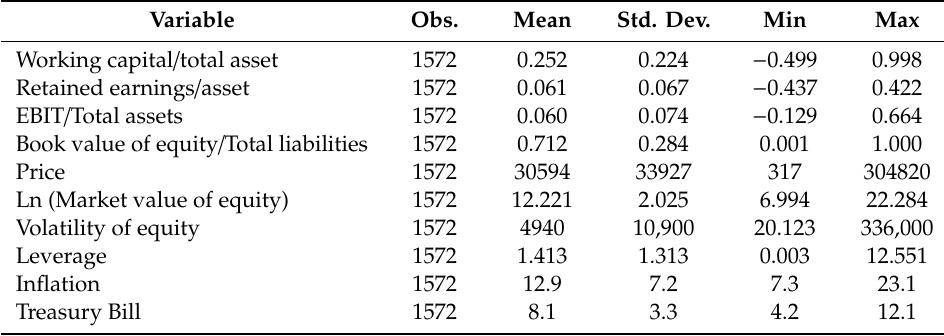
Table 3. Summary statistics for explanatory variables during the GFC (2007–2009).